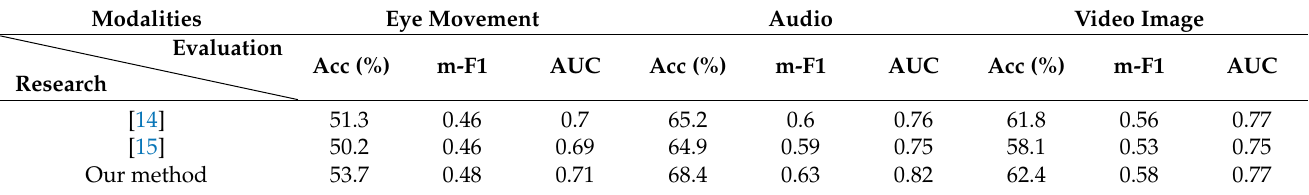
Table 3. Comparison with the other adaptive window